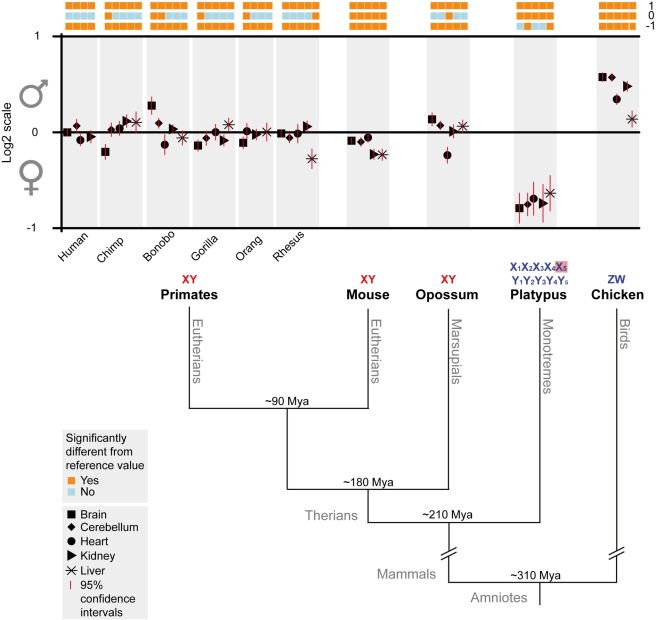
Median male versus female expression levels of mammalian X-linked and avian Z-linked genes in five somatic tissues.Top: Median male to female (M∶F) gene expression level ratios and 95% confidence intervals for five somatic tissues derived from nine mammals and one bird. M∶F ratio calculations are based on genes expressed in both sexes (RPKM>0). Values are plotted on a log2 scale to allow for linear and symmetrical patterns (e.g., same distances for two-fold higher expression levels in males or females, respectively). Statistically significant deviations of M∶F ratios from key reference values (orange/blue boxes): 0.5 (log2 ratio of −1); 1 (log2 ratio of 0); and 2 (log2 ratio of 1), as assessed by one-sample Wilcoxon signed rank tests (Bonferroni corrected p<0.05). Numbers of X (X5, Z) genes considered in the analysis are: 664 (human), 520 (chimp), 657 (gorilla), 606 (orang), 731 (macaque), 750 (mouse), 442 (opossum), 137 (platypus), 733 (chicken). Bottom: Schematic tree illustrating the phylogenetic relationships and sex chromosomes (homologous therian XY chromosomes in red; [partially] homologous platypus and bird sex chromosomes in blue) of the amniote lineages for which male and female expression was compared. Specifically, male and female expression values were compared for the therian X, platypus X5 (highlighted in pink), and chicken Z chromosome. Approximate divergence time estimates (million years ago [Mya]) are based on previous studies [52]–[55]. Note that the expression ratios shown for eutherians are based on protein-coding genes from the entire X chromosome, that is, the ancestral part of the eutherian X (the so-called XCR) [31], as well as the region that became X-linked during early eutherian evolution (termed XAR) [31]. Expression ratios for the XCR only are shown in Figure S1.